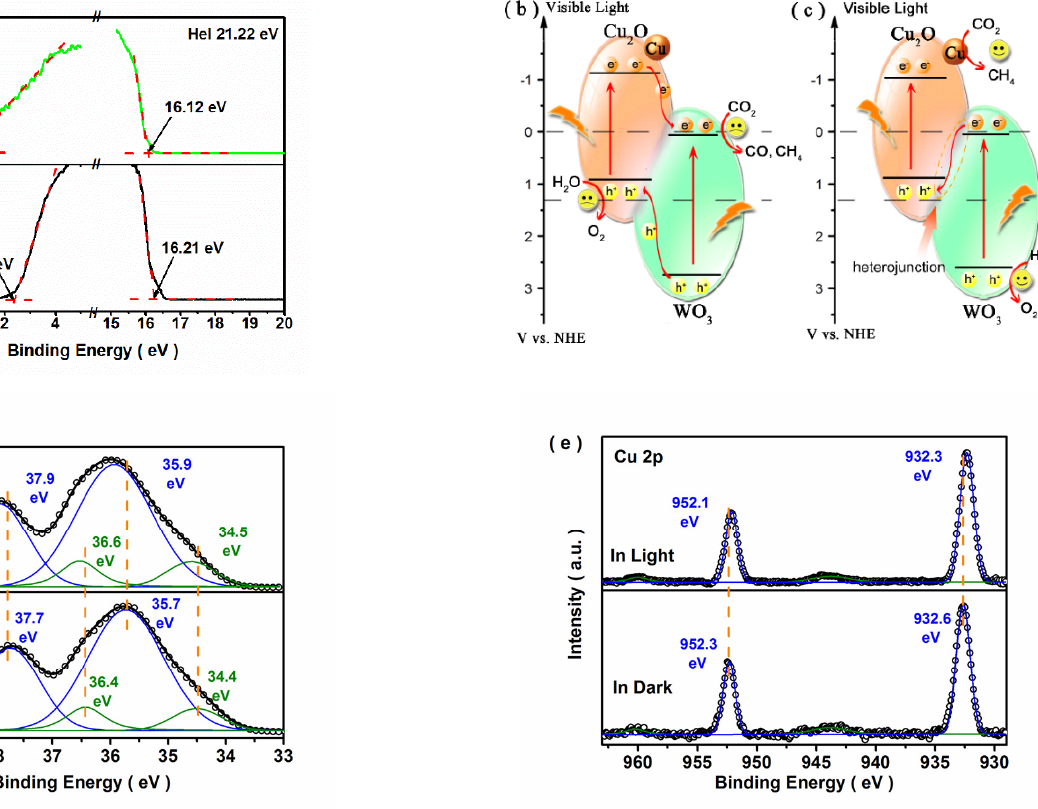
Figure 8. Ultraviolet photoelectron spectra of Cu 2 O and WO 3 samples measured at the basics of − 8 V ( a ), photocatalytic electron transfer modes of the Cu/Cu 2 O/WO 3 composite: the traditional double transfer mode ( b ) and the S-scheme charge transfer mode ( c ), and XPS spectra of W 4f ( d ) and Cu 2p ( e ) for Cu 2 O/WO 3 heterojunction in dark/light.